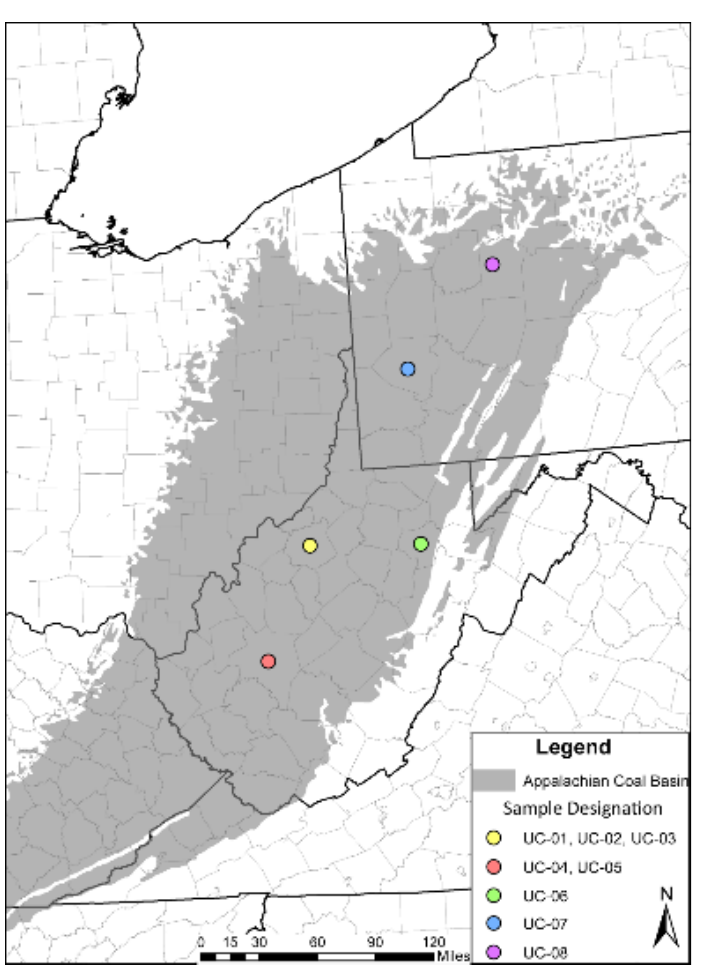
Figure 1. Map of the Appalachian coal basin and the location of samples designated in Table 1.